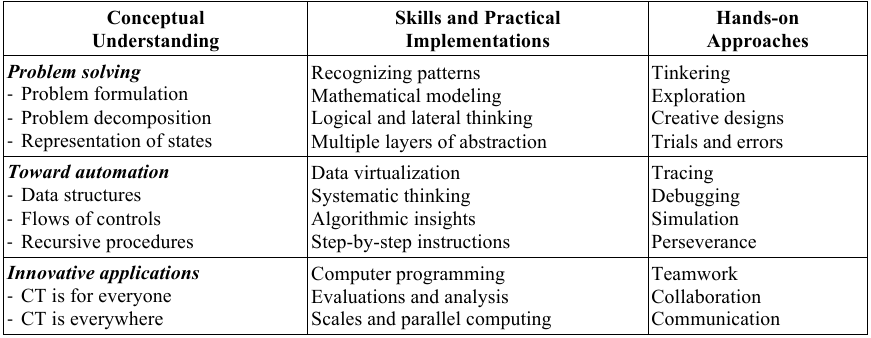
Table 2. Essences of CT are organized into conceptual foundations, compulsory skill sets, and how to approach them hands-on. Learning of these CT skills are divided into three suc- cessive phases: elementary problem solving, intermediate algorithmic thinking toward automation, and their everyday functions in innovative